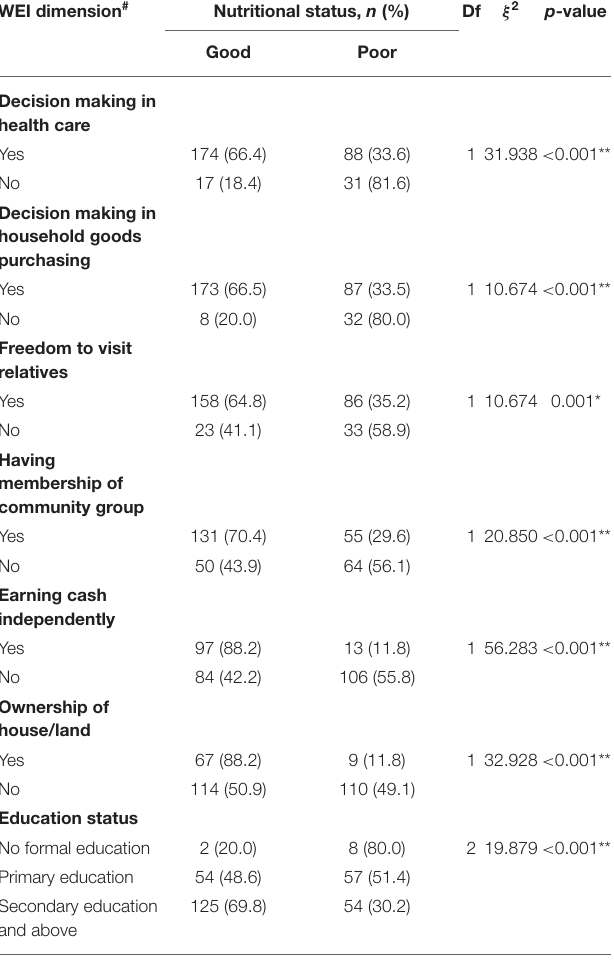
TABLE 5 | Association between various dimensions of maternal empowerment and children’s nutrition. WEI dimension # Nutritional status, n (%) Df ξ 2 p